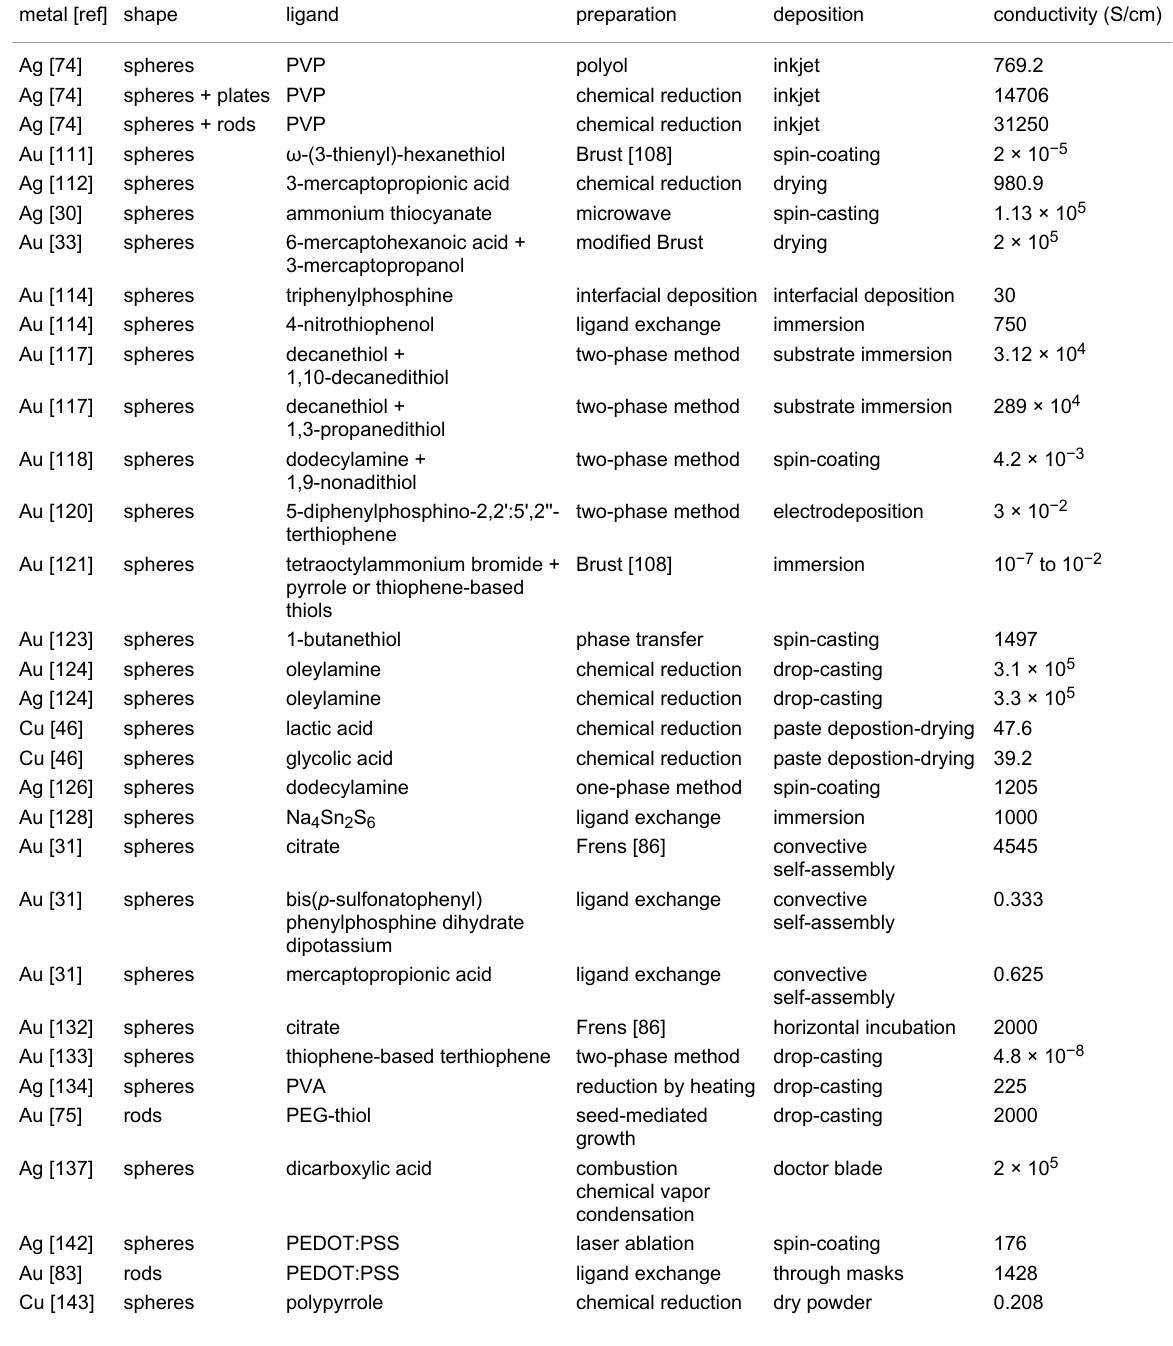
Table 2: Particle synthesis routes and deposition techniques reported for the preparation of coinage metal nanoparticles and their conductive films. metal [ref]